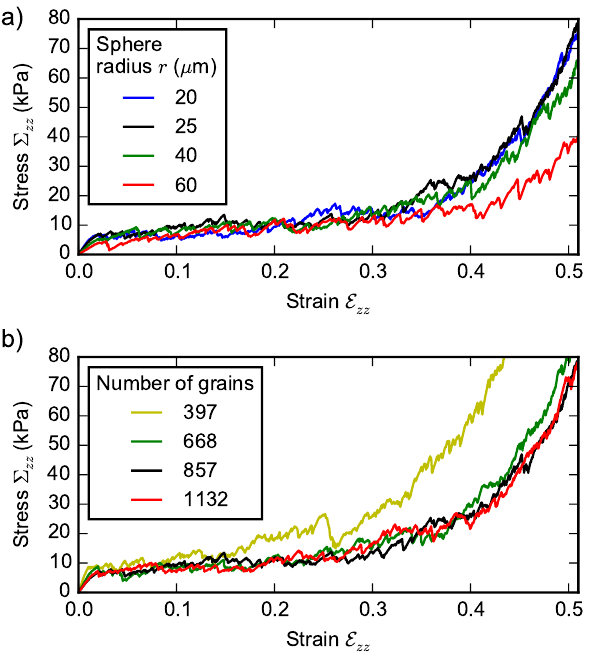
Figure 8. Simulated stress–strain curves for different microscopic friction coefficients (a) and cohesion strengths (b) . Note that, in (b) the macroscopic stress ( y axis) is scaled by the microscopic strength σ ice and that the contact stiffness E varies here as E = 10 × σ ice in order to keep a constant microscopic strain at